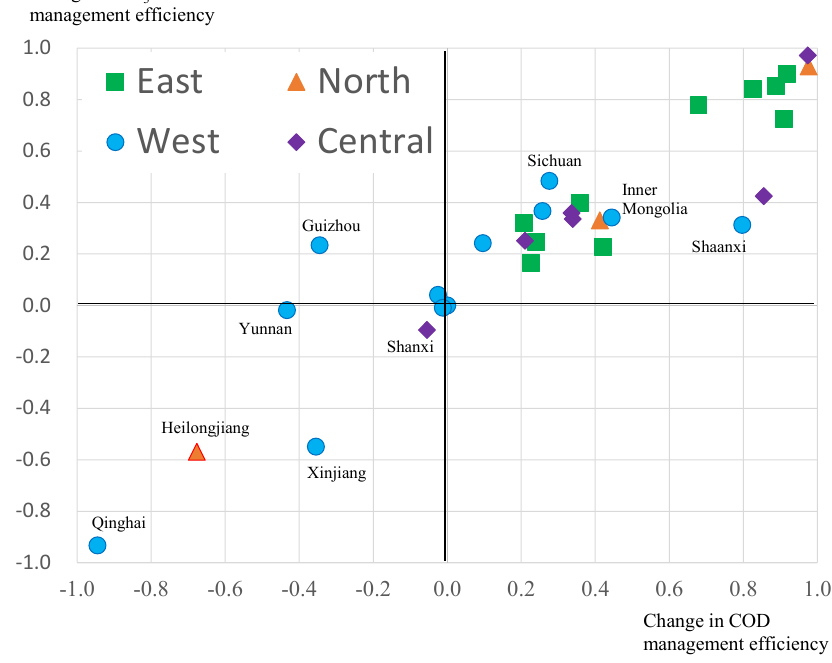
Figure 5. Changes in the COD and NH 3 ‐ N emission management efficiencies from 2004 to 2014 by region.